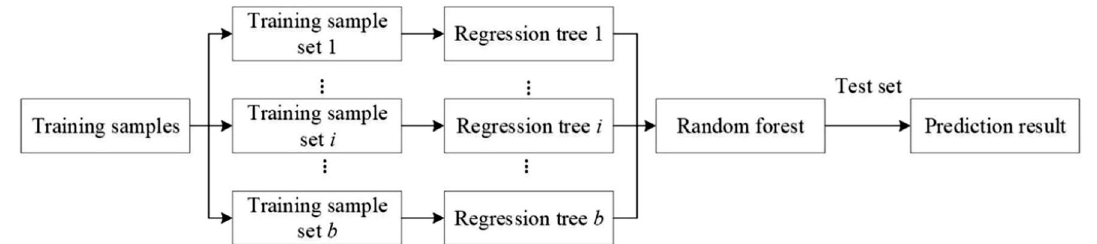
Fig. 4 Flow diagram of the random forest